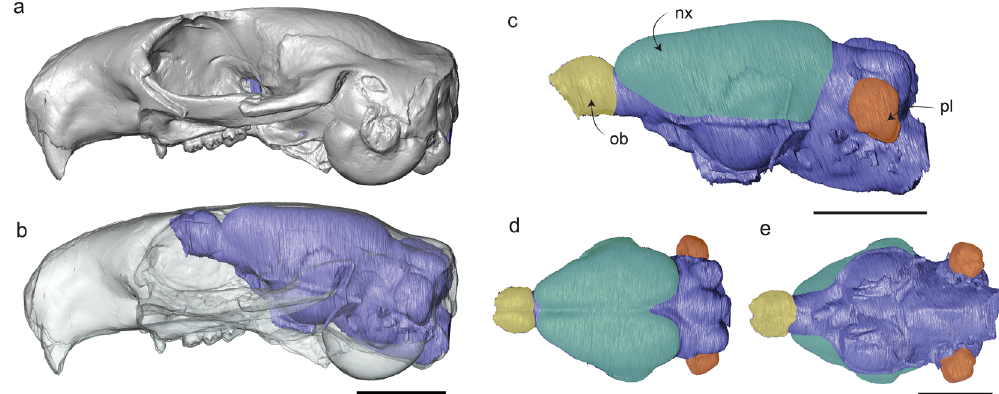
Fig. 1 Virtual endocast of the early Oligocene squirrel Cedromus wilsoni (USNM 256584) based on computed tomography (CT) data. a lateral view inside a solid cranium; b lateral view inside a translucent cranium; c lateral view with the different regions estimated in the paper highlighted; d dorsal view; e ventral view. nx neocortex, ob olfactory bulb, pl petrosal lobule. Scale bars equal 10